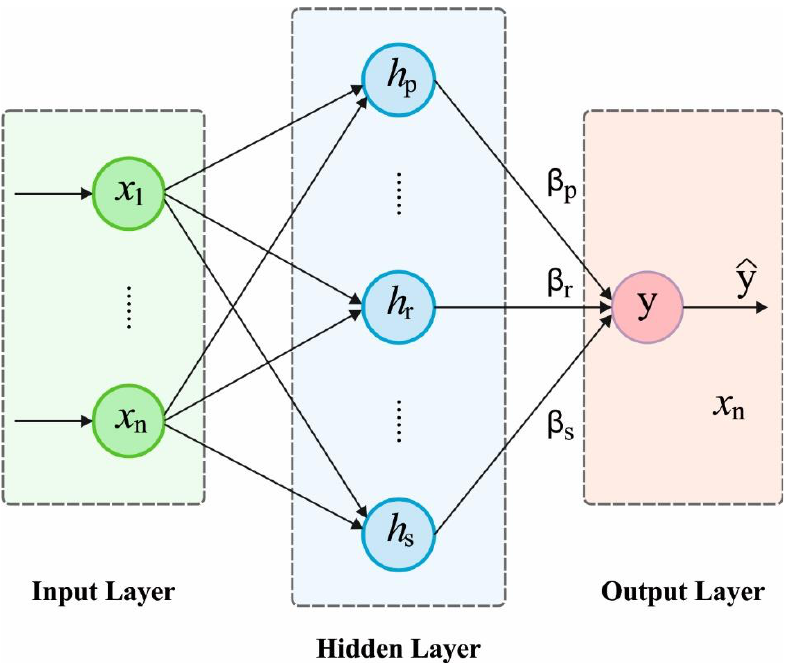
Figure 2. Structure of RVFL.